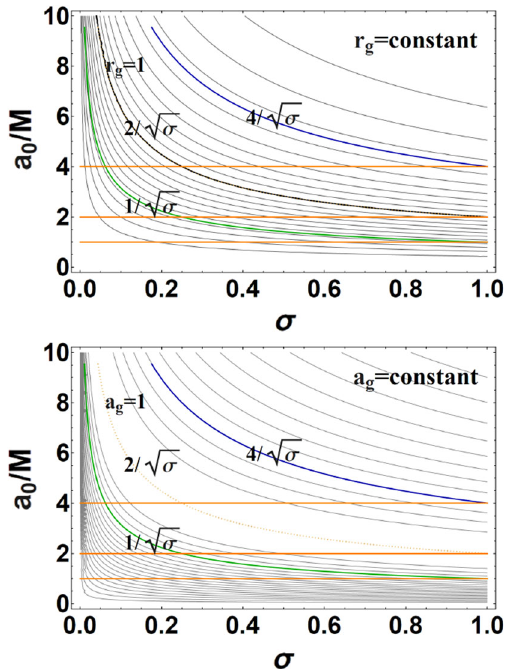
Fig. 3 Plot of the constant bundle tangent radius r g / M and tangent spin a g / M on the plane σ ∈ [ 0 , M ] and for a 0 > 0. Special values and curves are also show. These special values play an essential role for the characteristic frequencies of the bundles (see also Sect. 3.2). It refers to the analysis of Eq.